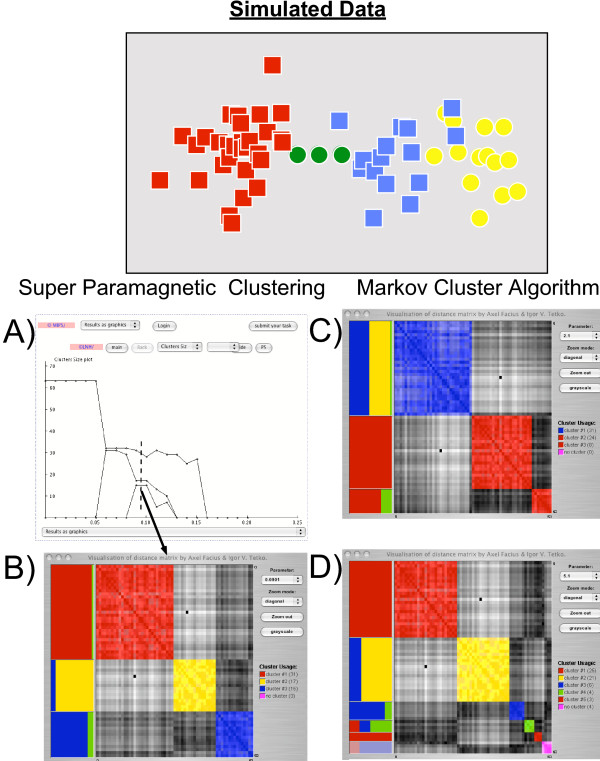
Clustering of Artificial Data Set using SPC and TRIBE-MCL algorithm. The red, blue and yellow colors correspond to three distributions used to generate the data. The noise between the data points from distributions 1 and 2 is indicated as green circles. A) Cluster size plot of SPC algorithm. The vertical line indicates temperature when calculation of the distance matrix B) was performed. B) The distance matrix calculated for the SPC clusters at temperature T = 0.087. More intense colors correspond to smaller distances between points. The diagonal and off-diagonal elements correspond to inter- and intra- cluster distances, respectively. Each horizontal block on the left side of Figure corresponds to one cluster and the colors are used to indicate composition of samples from different distributions. C) and D) are the distance matrices calculated for the TRIBE-MCL clusters obtained using inflation parameter 2.1 and 5.1, respectively.